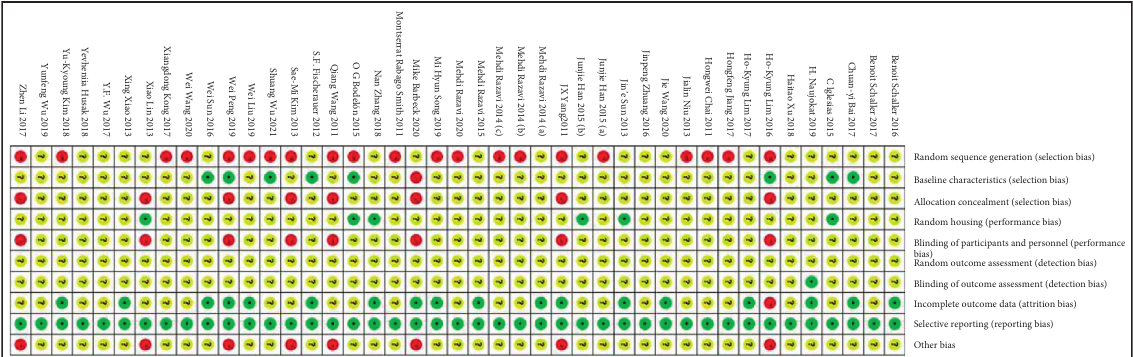
Figure 4: Risk of bias in each included 43 studies.